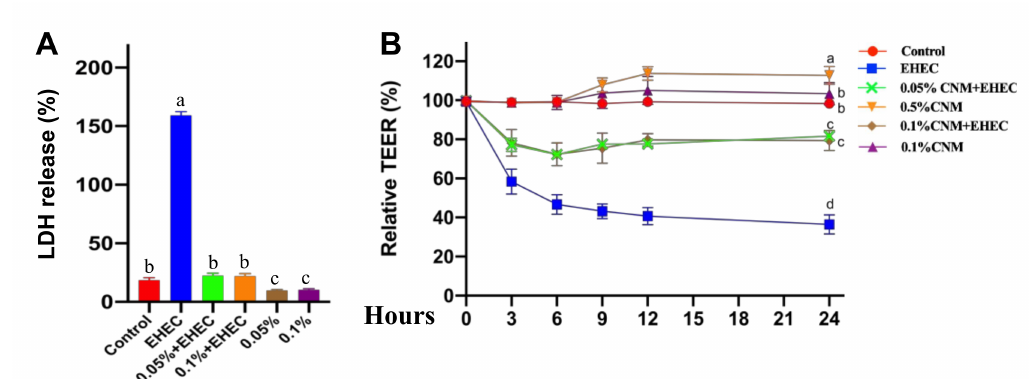
Figure 4. CNMs ameliorated E. coli O157 -induced epithelial function damage in IPEC-J2 cells. Monolayer IPEC-J2 cells were cultured with or without CNMs in the absence or presence of E. coli O157 . LDH release ( A ) and TEER ( B ) were determined. Data are the means ± SEM of three independent experiments. Means with different lowercase letters differ significantly ( p <